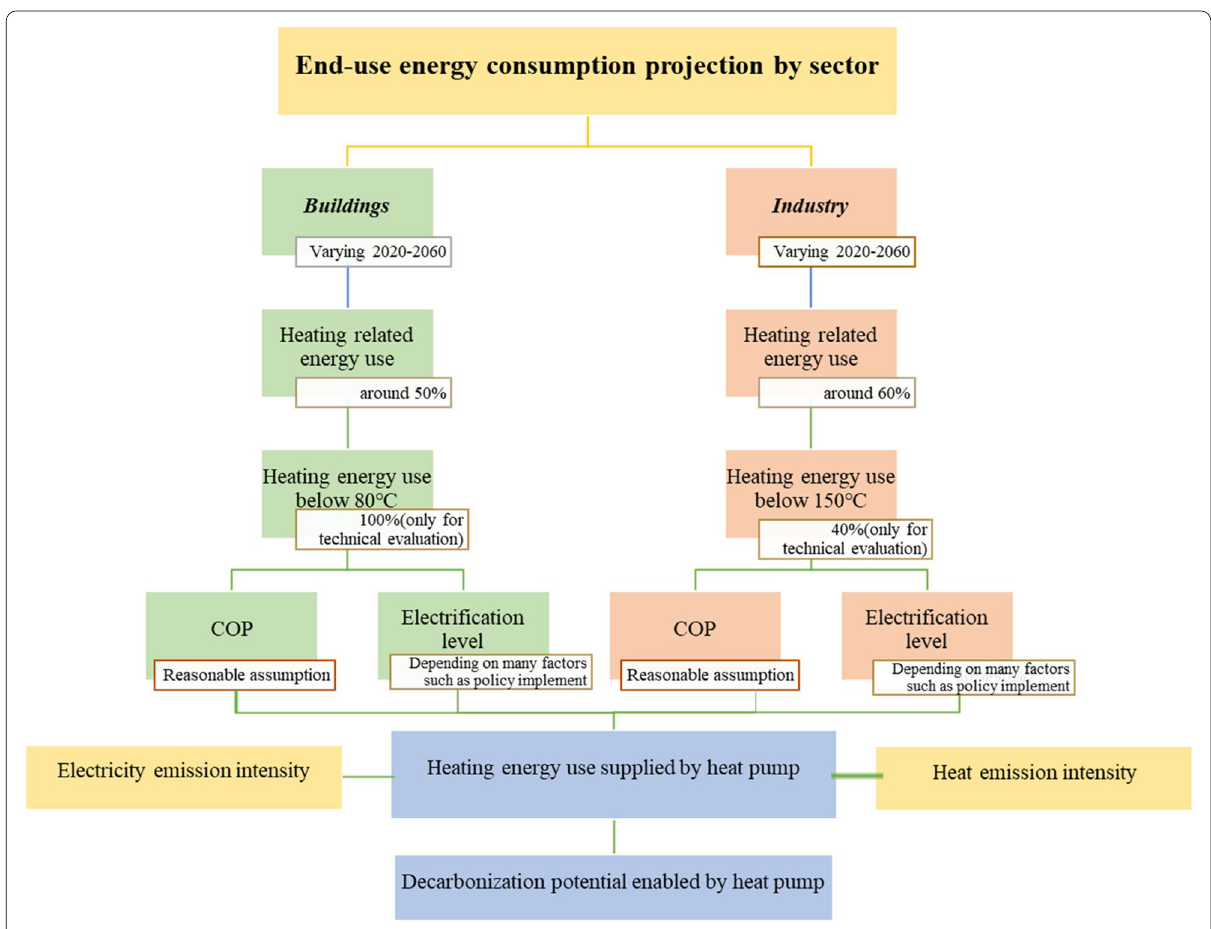
Fig. 8 Flow chart of the quantification of the heating decarbonization potential by heat